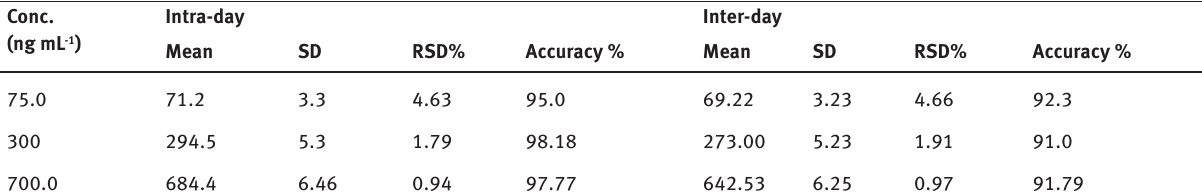
Table 4 : Intra- and inter-day accuracy and precision of lixivaptan quality control samples determined for the investigated HPLC method. Conc.